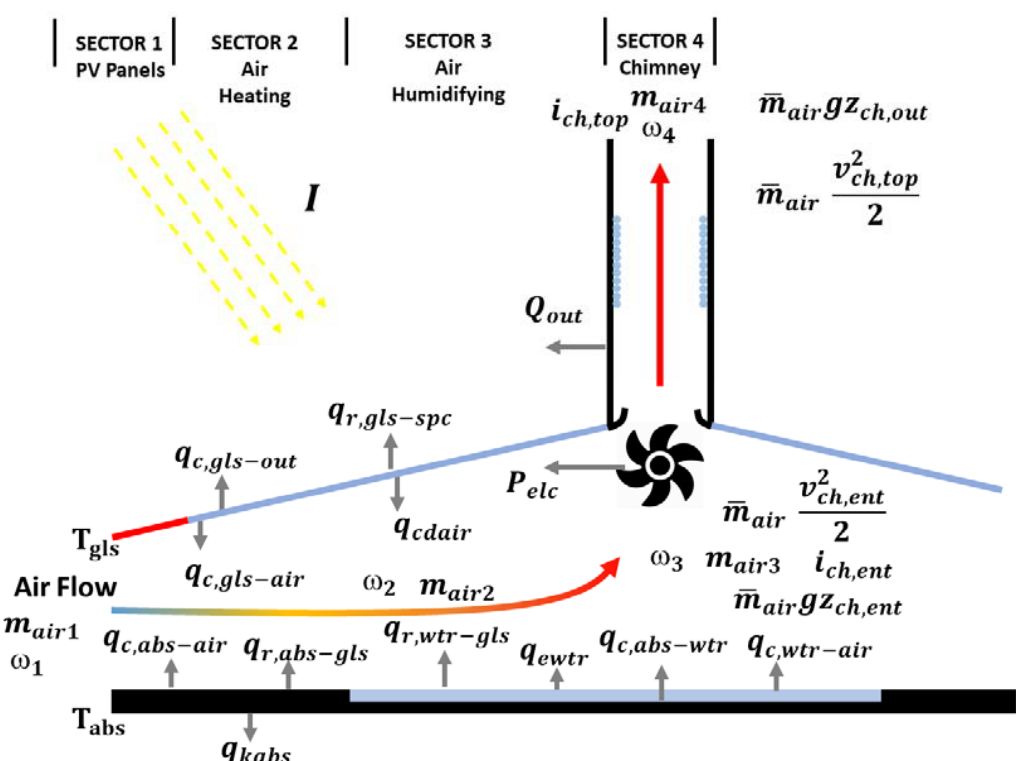
Figure 2. Diagrams to represent the energy balance equations showing sector 1, sector 2, and sector 3 of the PV-SCPP.